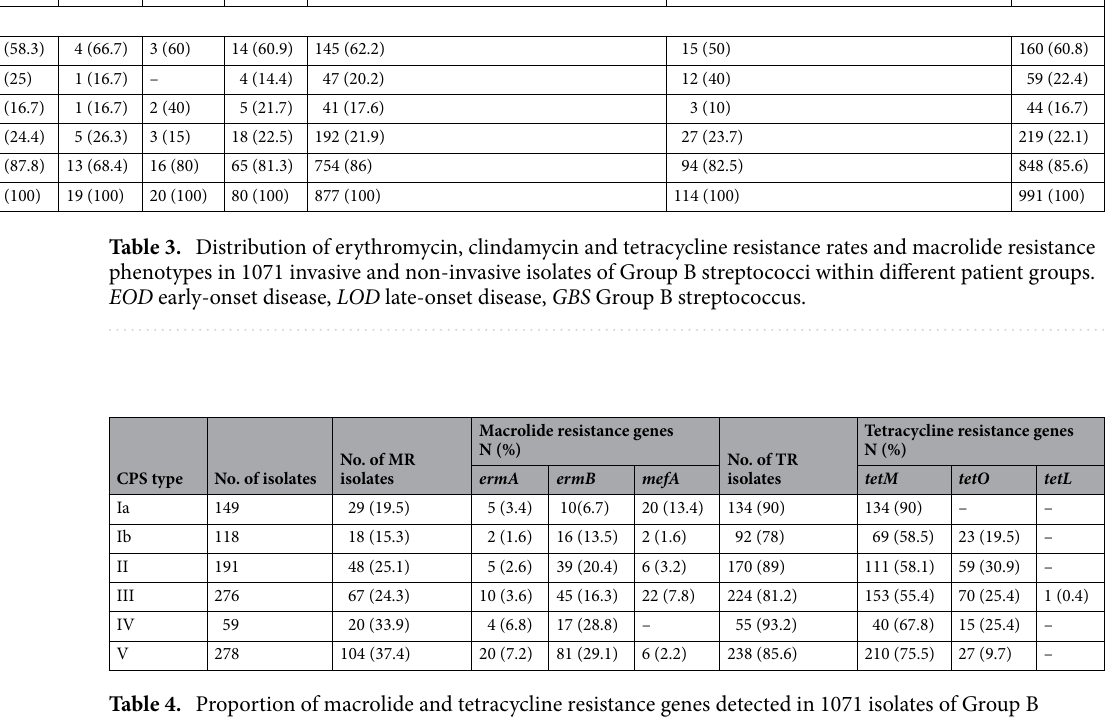
Table 4. Proportion of macrolide and tetracycline resistance genes detected in 1071 isolates of Group B streptococci within capsular types. CPS capsular polysaccharide, MR macrolide resistance, TR tetracycline